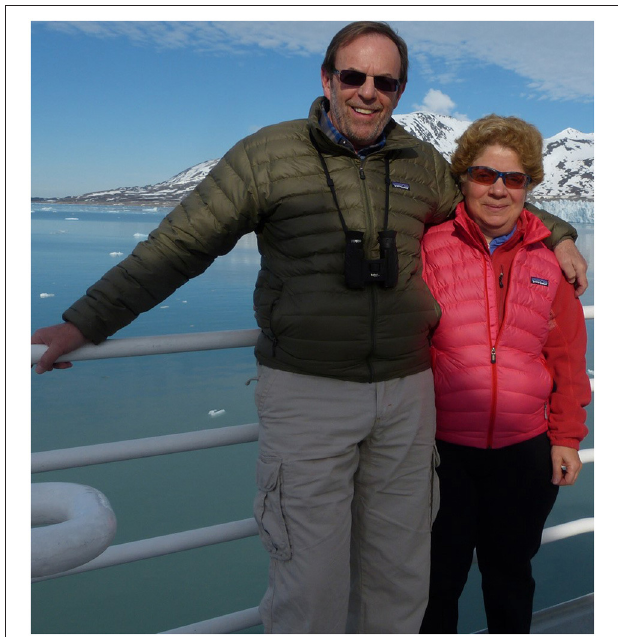
FIGURE 1 | Alan and Ellen Gintzler on